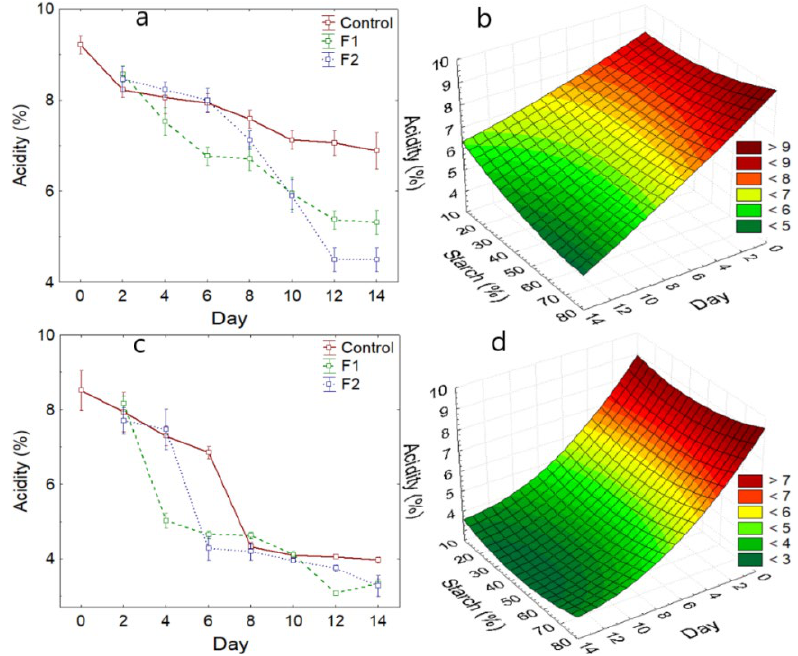
Figure 3. Acidity variation, ( a ) Hass variety, ( b ) with respect to the addition of starch—Hass variety, ( c ) Fuerte variety, ( d ) with respect to the addition of starch—Fuerte variety.